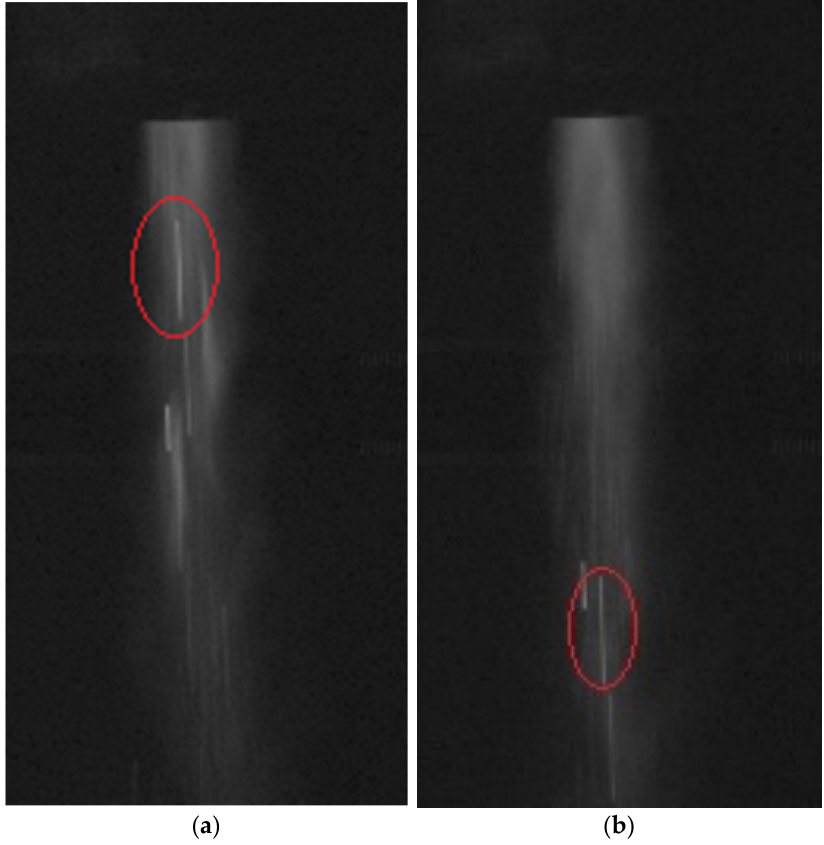
Figure 3. A frame of video footage at ( a ) 1.314811 s and ( b ) 1.314862 s.